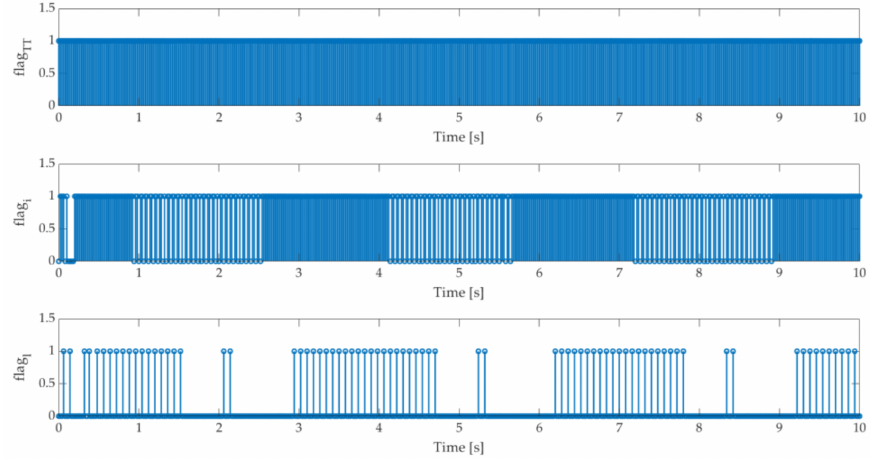
Figure 7. Update flags of the controllers u TT , u i and u l .